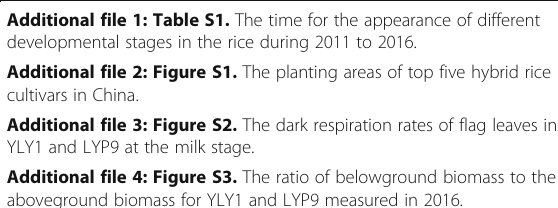
Additional file 1: Table S1. The time for the appearance of different developmental stages in the rice during 2011 to 2016. Additional file 2: Figure S1. The planting areas of top five hybrid rice cultivars in China. Additional file 3: Figure S2. The dark respiration rates of flag leaves in YLY1 and LYP9 at the milk stage. Additional file 4: Figure S3. The ratio of belowground biomass to the aboveground biomass for YLY1 and LYP9 measured in